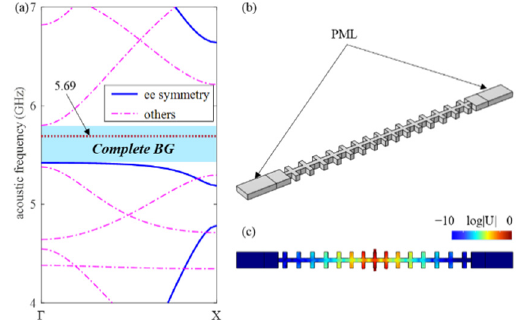
Figure 7. ( a ) The complete band structure of the PnC with nominal unit cells. ( b ) The model to calculate clamping losses. ( c ) Logarithm normalized displacement field of acoustic cavity mode at 5.69 GHz. Table 2. A performance comparison among different types of resonators operating at